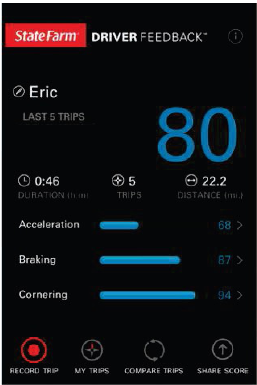
Figure 4. Smartphone interface for a behaviour based insurance scoring application